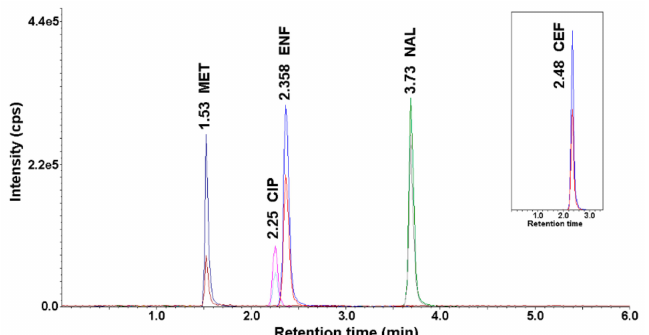
Figure 1. Chromatogram of antimicrobials standard solution (concentration 50 ng mL − 1 ) after application of the developed high-performance liquid chromatography coupled with an ultraviolet (UV) detector and a tandem mass spectrometer (HPLC-UV-MS/MS)